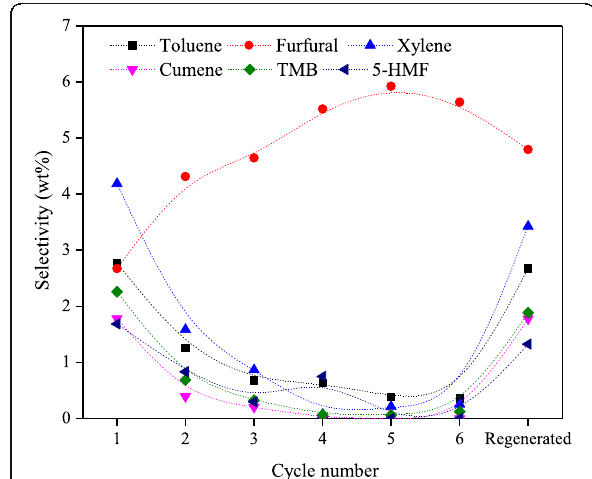
Fig. 6 Compounds selectivity in consecutive cycles of PS pyrolysis over Ni(5) Z